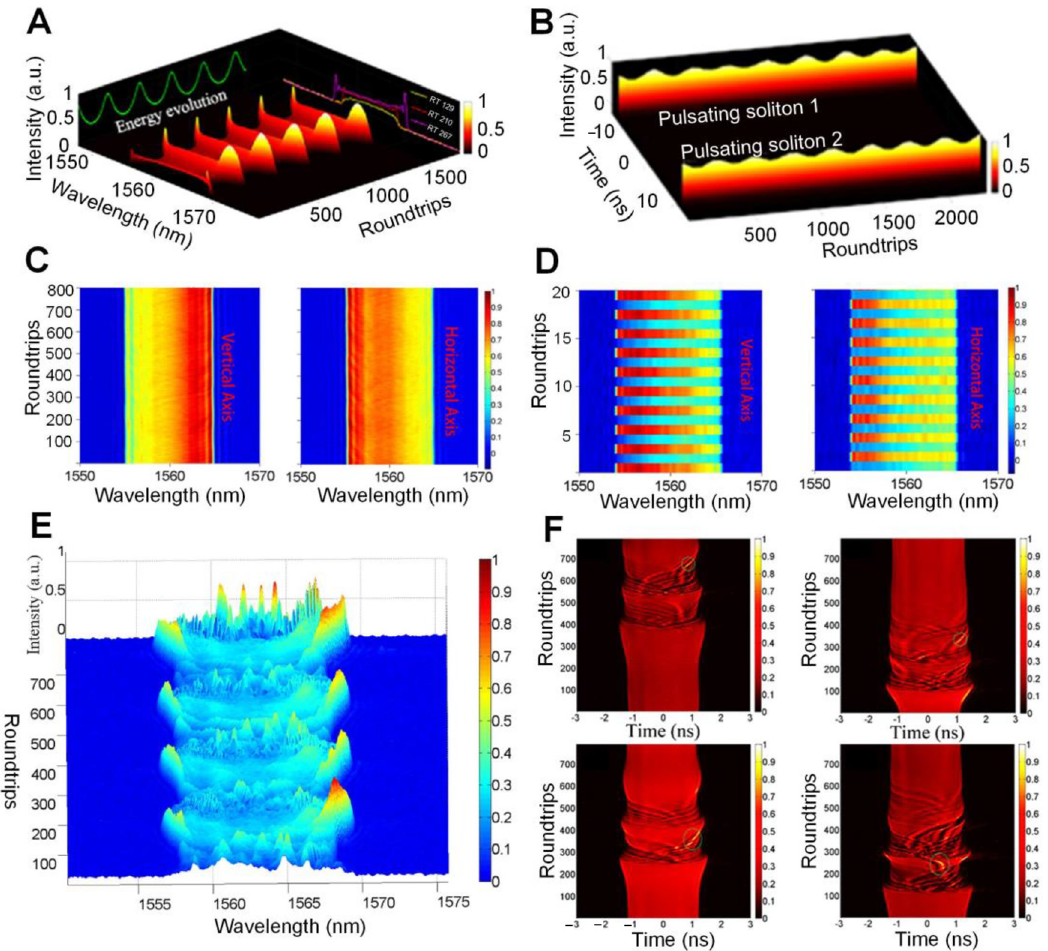
Figure 16: Various steady-state dynamics of soliton. (A) Single-shot spectra and corresponding energy evolution dynamics of single-soliton pulsation; (B) Single-shot spectra evolution of single-soliton pulsation; Xu et al. [180]. © Optical Society of America 2019. (C) Single-shot spectraevolutiondynamicsofGLVS.(D)Single-shotspectraevolutiondynamicsofPRVS.Liuetal.[181].©OpticalSocietyofAmerica2017.(E) Shot-to-shot spectra in “ successive soliton explosions ” regime. Liu et al. [178]. © Optical Society of America 2016. (F) Spectral evolution dynamics of four typical single-shot pulse-trains in soliton explosion regime. Liu et al. [179]. © Optical Society of America